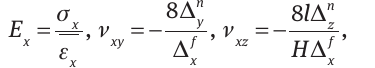
model by assigning a displacement of master nodes.